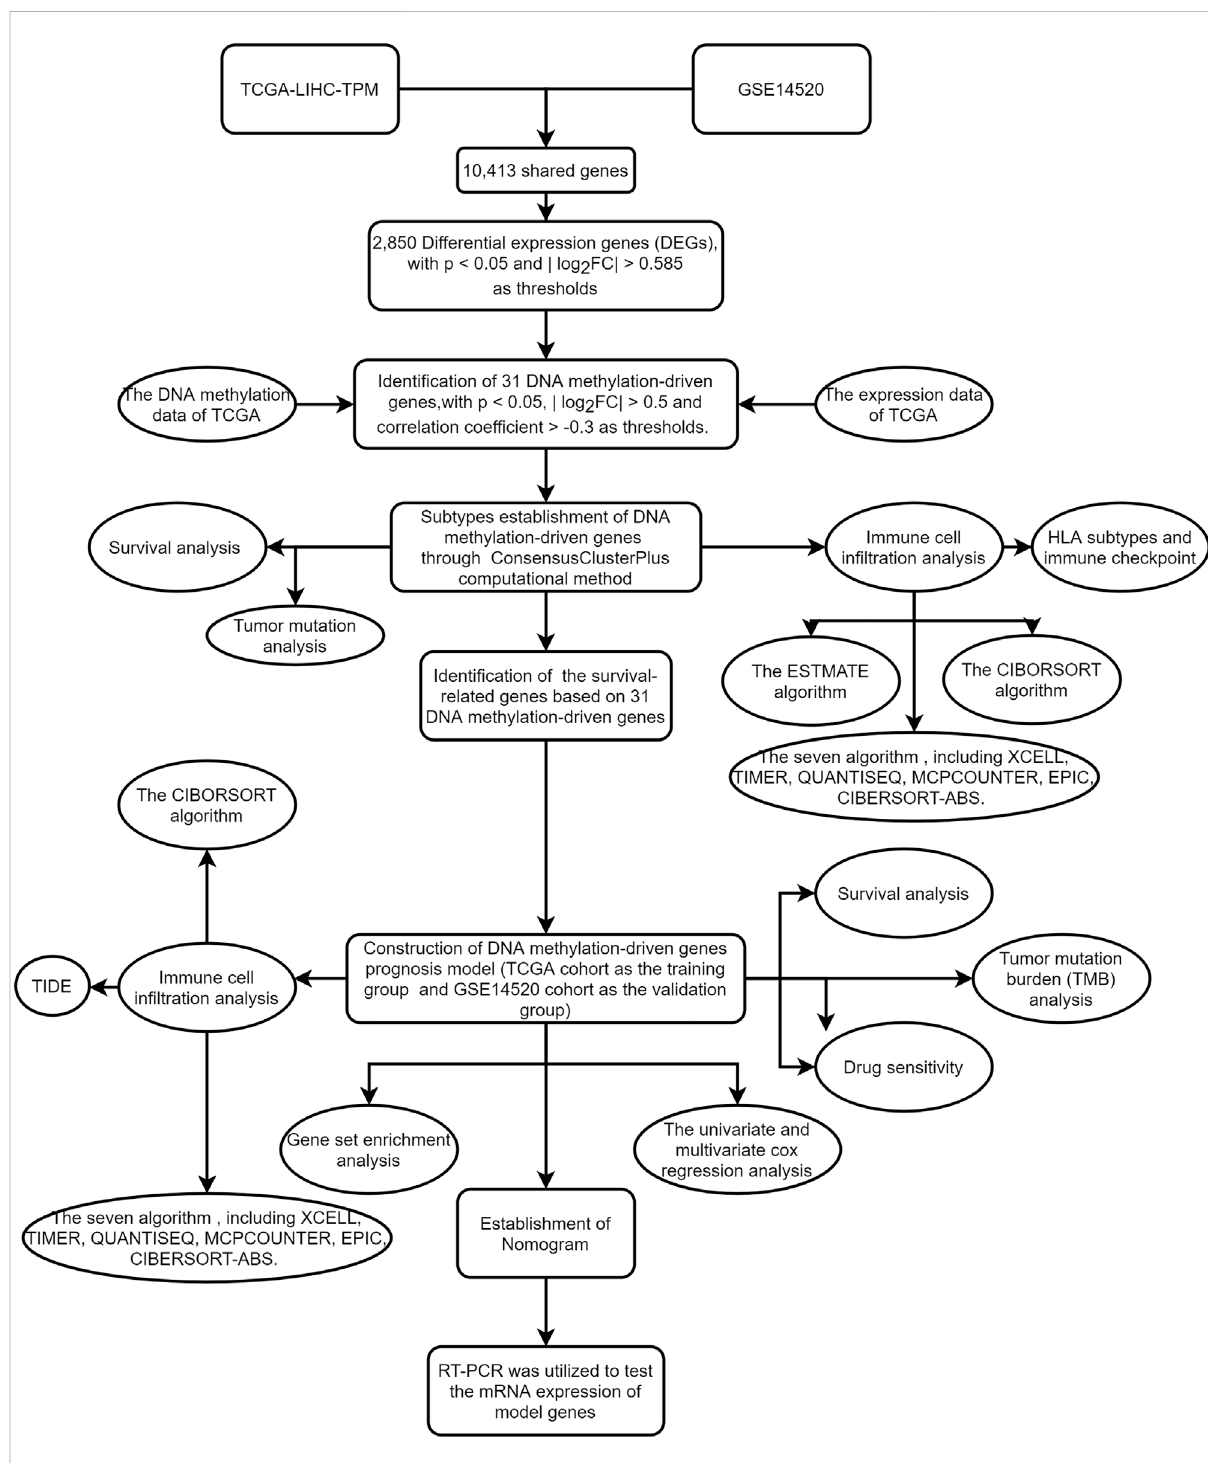
FIGURE 1 The work fl ow of the